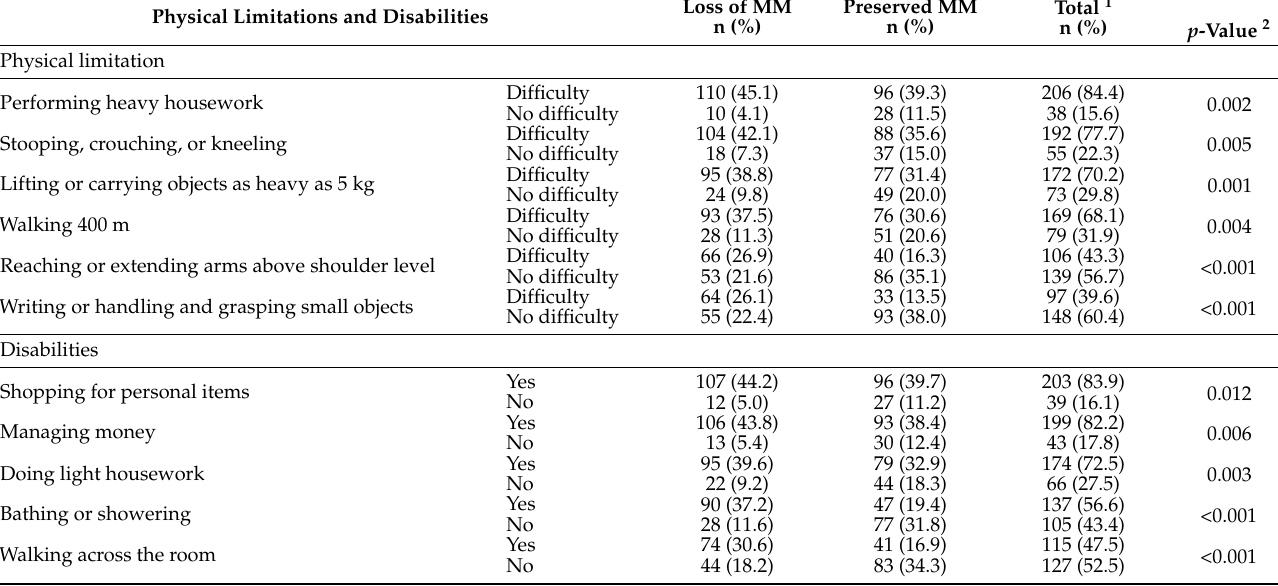
Table 2. Association of physical limitation and disability with calf circumference in older adults living in LTCF. Natal, RN, Brazil.